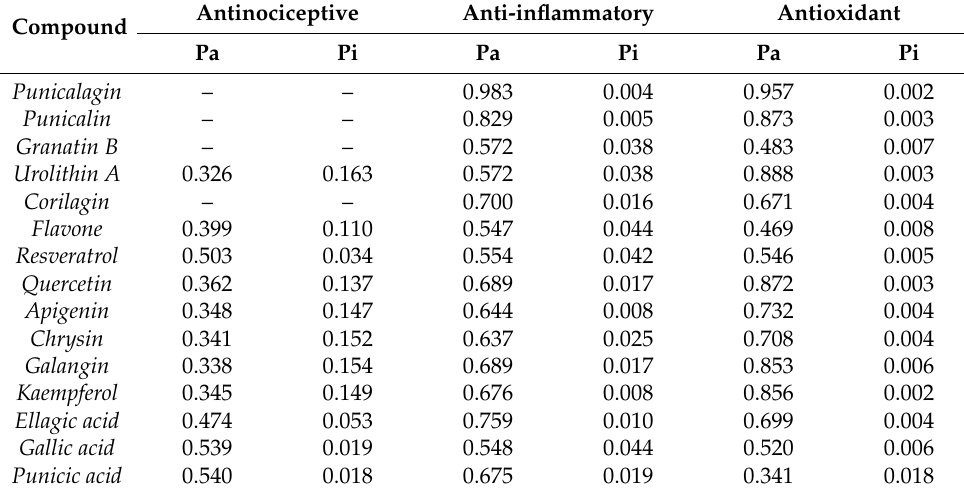
Table 1. Pharmacological activities predicted for major compounds by PASSonline.